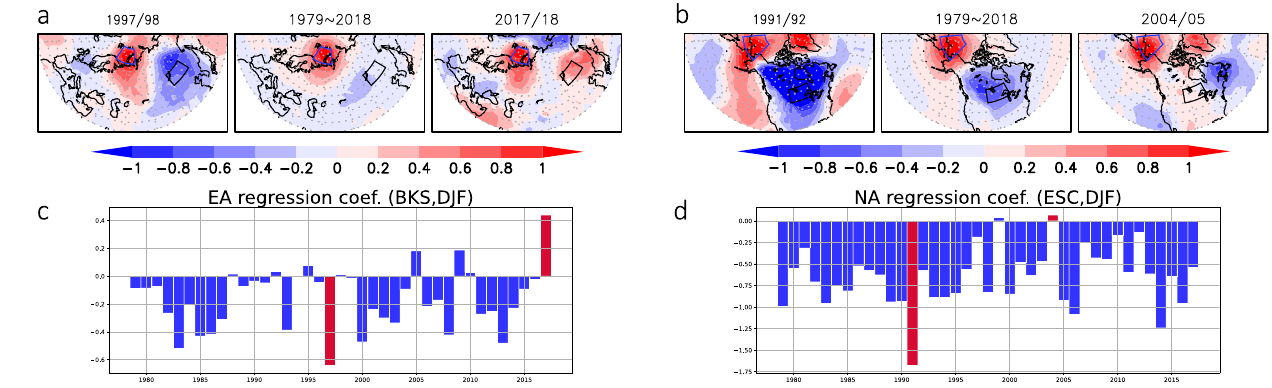
Fig. 1 Interannual variation of WACC. Regression coef fi cient of 850hPa temperature anomalies with respect to ( a ) the Barents-Kara sea (30° – 70°E, 70° – 80°N) and ( b ) East Siberia Chukchi sea (160° – 200°E, 65° – 80°N) 850hPa temperature anomalies during 1979/80-2017/18 winters from ERA-interim daily reanalysis data. Middle shows the regression coef fi cient from 1979 to 2018. Left and right shows the regression coef fi cient that is analyzed for 90 days when the regression coef fi cient is the smallest and biggest. c , d Time series of the regression coef fi cients of 850hPa temperature anomalies in East Asia (105° – 125°E, 47° – 55°N) and North America (255° – 275°E, 45° – 53°N) with respect to the Barents-Kara sea (30° – 70°E, 70° – 80°N) and East Siberia Chukchi sea (160° – 200°E, 65° – 80°N) 850hPa temperature anomaly during 1979/80- 2017/18 winters (DJF), respectively. Black boxes indicate ( a ) the East Asia (105° – 125°E, 47° – 55°N) and ( b ) North America (255° – 275°E, 45° – 53°N). Blue boxes indicate ( a ) the Barents-Kara sea (30° – 70°E, 70° – 80°N) and ( b ) East Siberia Chukchi sea (160° – 200°E, 65° –